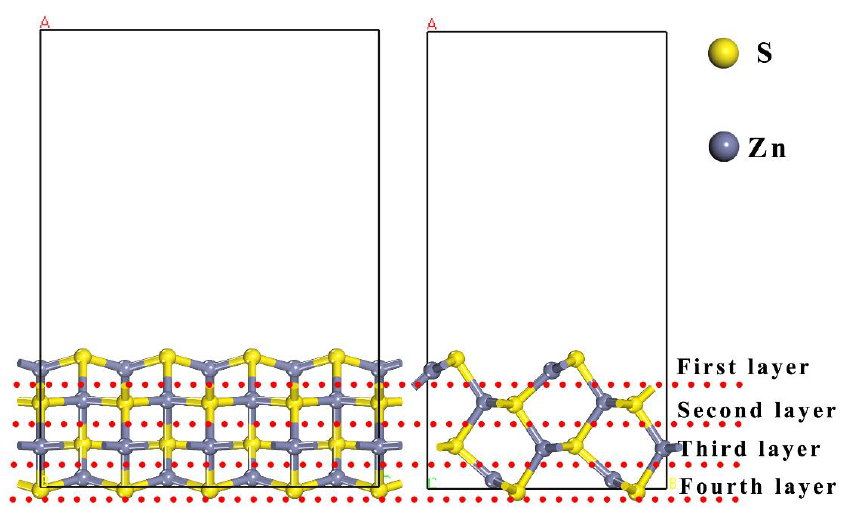
Figure 1. Sphalerite (110) surface after geometric optimization (2 × 2 × 2 supercell model). Qiu et al. conducted a comparative study on the possible adsorption sites of CN − in sphalerite (110) and found that the top site was the site with the strongest adsorption capacity [23]. In order to better discuss the results of geometric optimization and carry out the next calculation, the adsorption points used by subsequent ions are all top positions, which are shown in Figure 2.